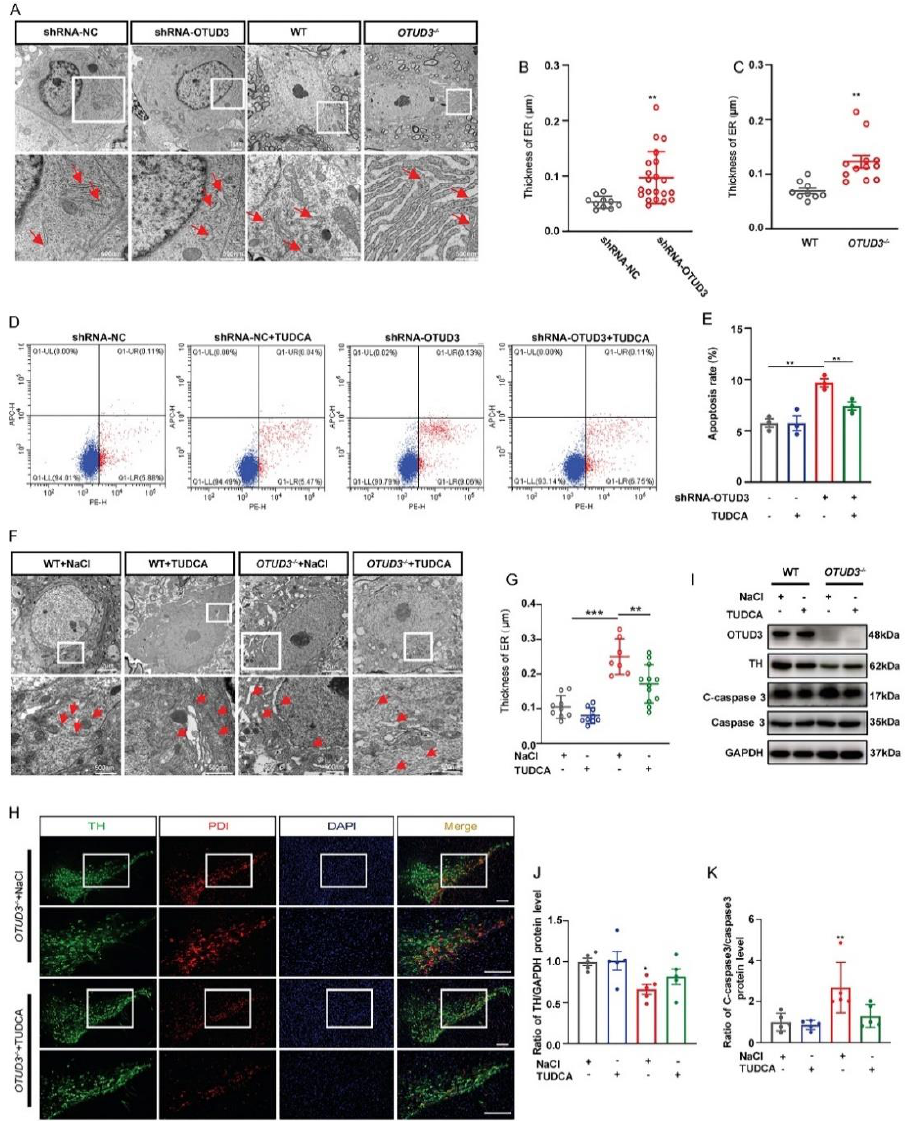
Figure 2. Effects of knockdown OTUD3 on ER stress. ( A – C ) Transmission electron microscope was applied to assessment of ER shape and statistical analysis of ER thickness, n = 9; red arrows represent the ER. ( D , E ) Cell apoptosis and statistical analysis of apoptosis rate by flow cytometer with PE Annexin V/7-ADD double staining, n = 3. ( F , G ) ER shape and statistical analysis of ER thickness in OTUD3 − / − mice after TUDCA treatment, n = 9. ( H ) Protein disulfide isomerase immunofluorescence staining of SN in OTUD3 − / − mice. Scale bar = 100 µ m. ( I – K ) Western blotting and statistical analysis of the expression of TH and the ratio of cleaved-caspase3/caspase3 proteins in OTUD3 − / − mice after TUDCA treatment, n = 5. Data were mean ± SEM, t -test, * p < 0.05, ** p < 0.01, *** p <